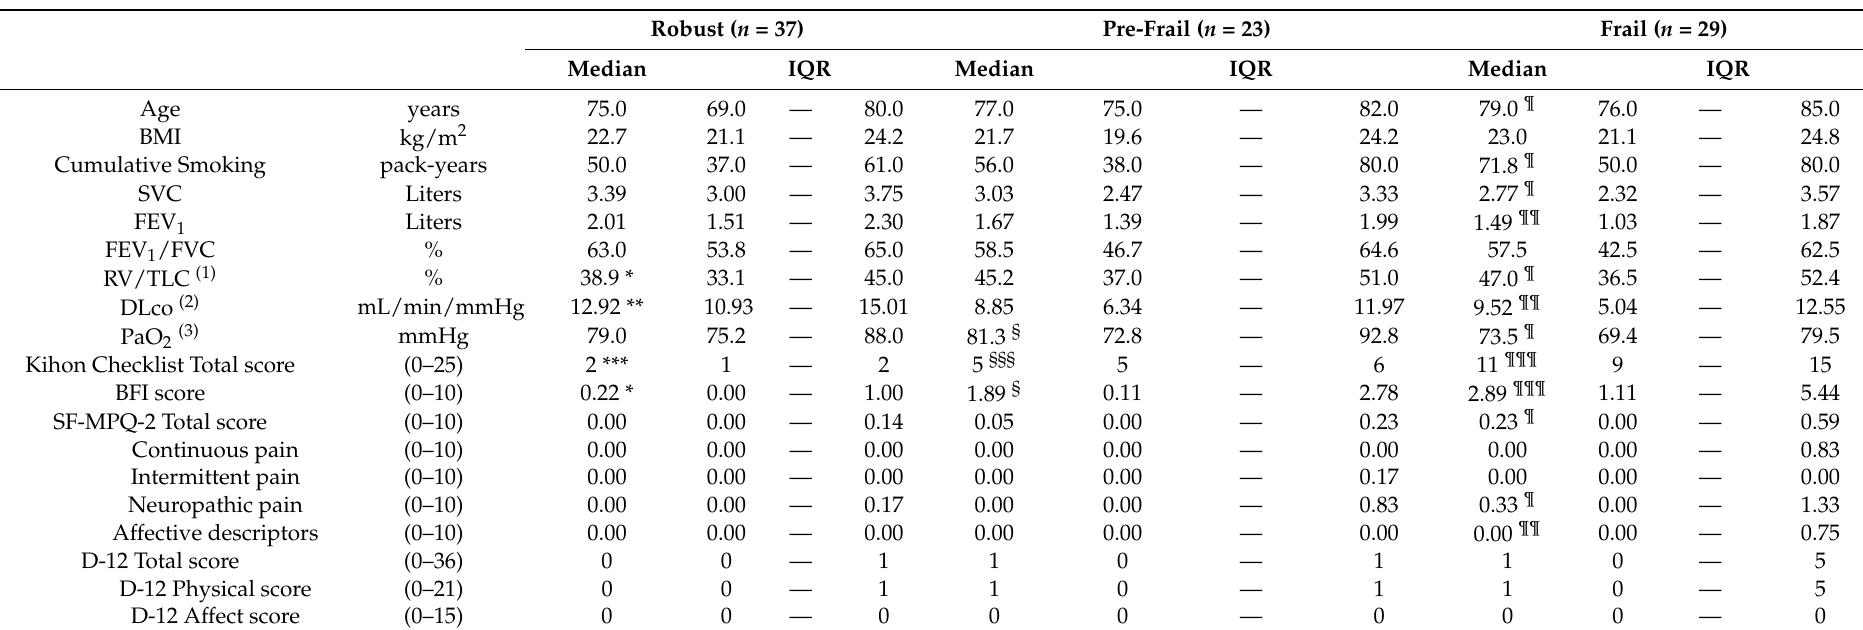
Table 4. Comparison of clinical indices and scores obtained from fatigue, pain and dyspnoea measurement tools between robust, pre-frail and frail groups classified by the Kihon Checklist in 89 subjects with